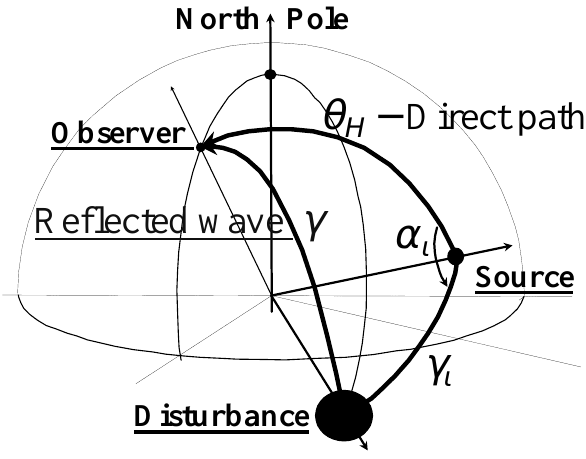
Fig. 2. Geometry of the wave scattering from a localized distur-